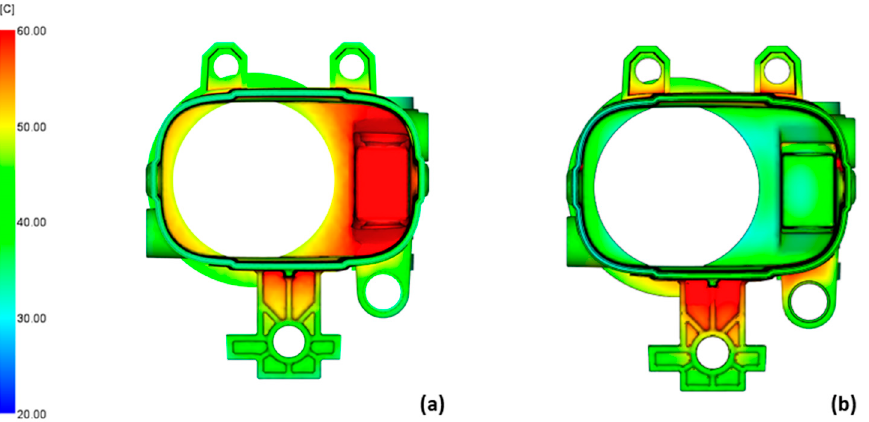
Figure 7. Temperature of the product for conventional cooling ( a ) and conformal cooling ( b ).